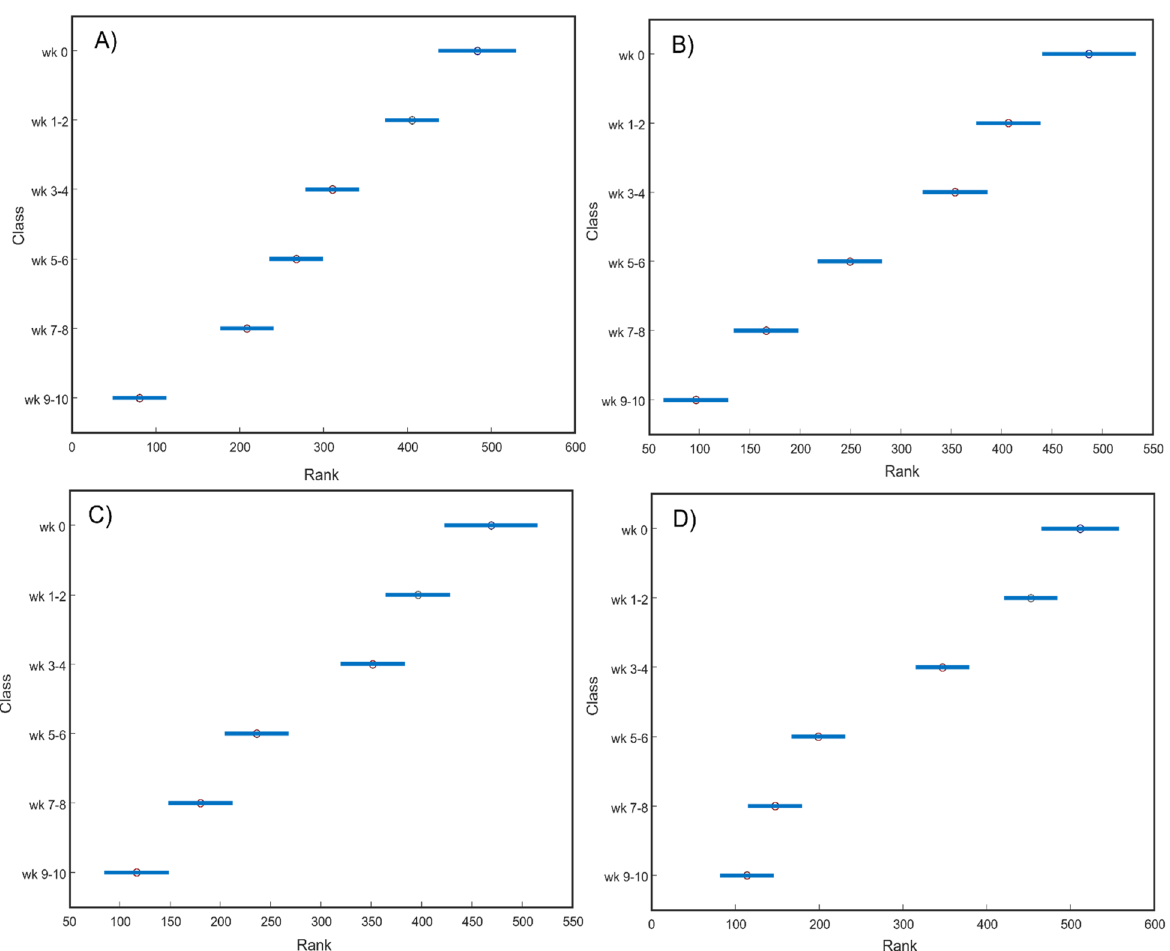
Figure 2. ANOVA graphs for ( A ) BLK P at 1433 cm –1 , ( B ) BLU P at 1157 cm –1 , ( C ) BLK S at 921 cm –1 and ( D ) BLU S at 1157 cm –1